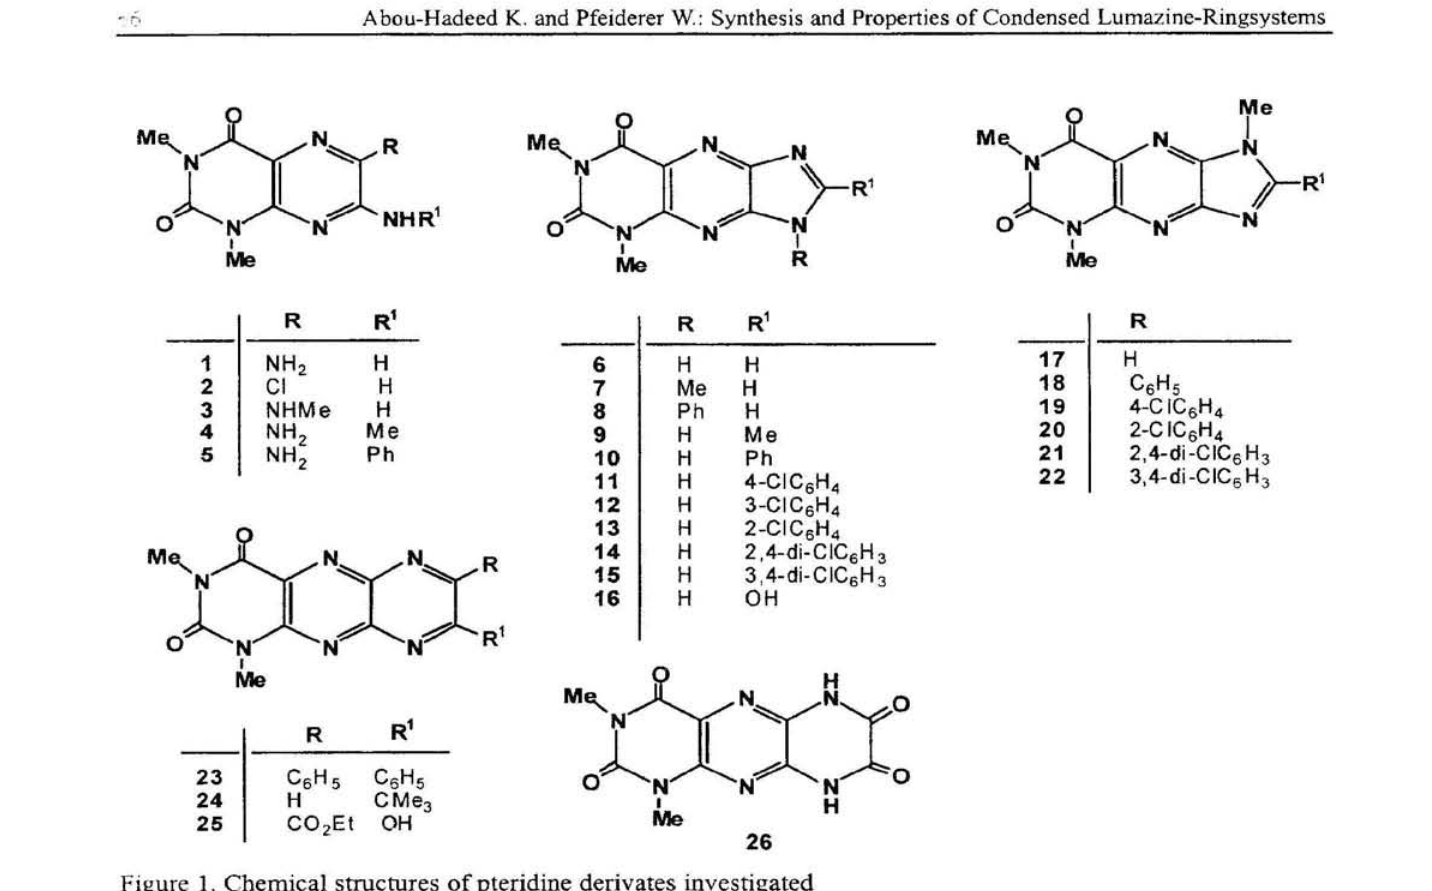
Figure 1. Chemical structures of pteridine derivates investigated from reaction of 6-chloro-l,3-dimethyllumazine-7- amine (2) (7) with methylammonium chloride in N- methylformamide and the isomeric